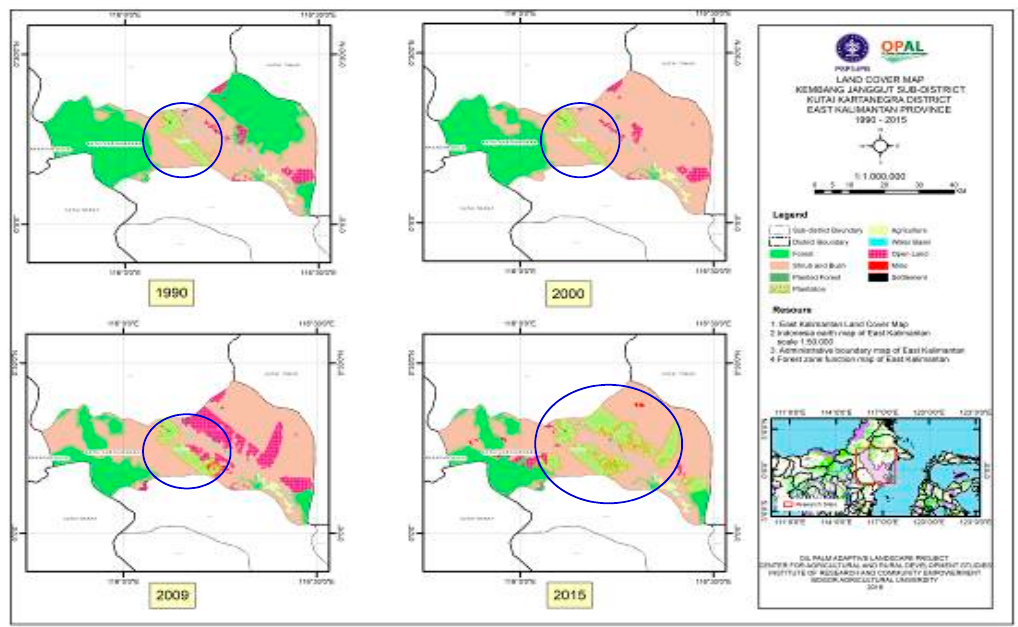
Figure 4. Land-cover changes in the Kembang Janggut sub-district between 1990 and 2015. Source: Secondary data, processed, 2018.